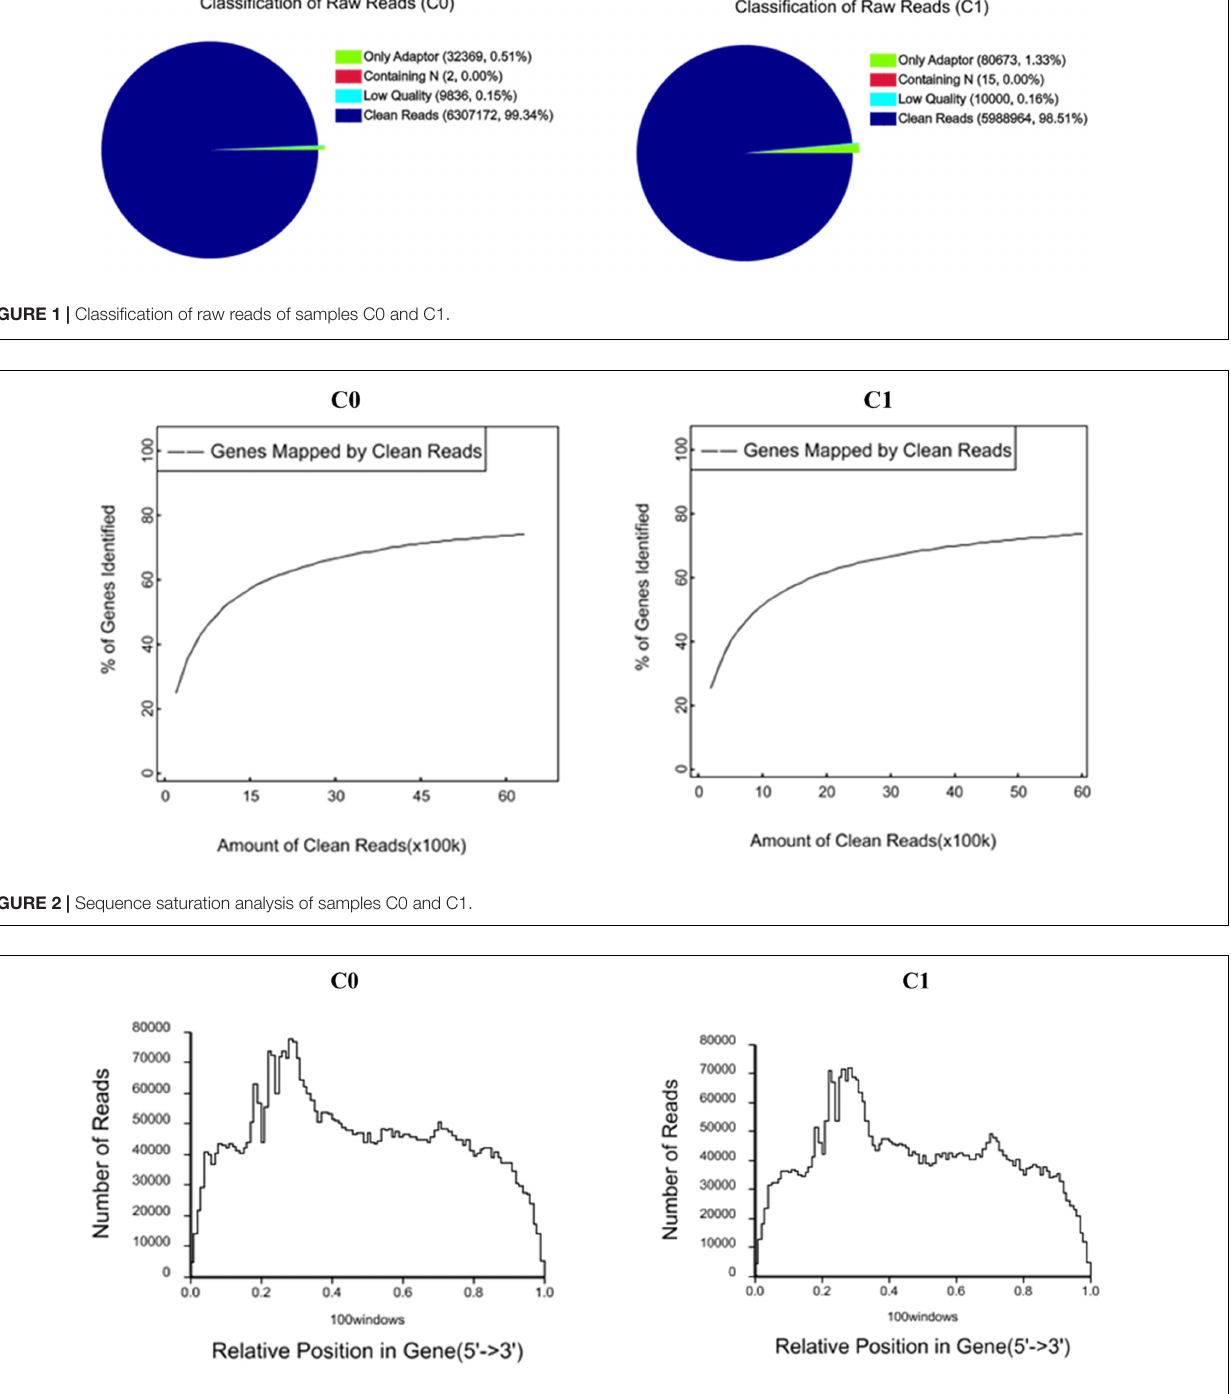
FIGURE 3 | Distribution of reads in samples C0 and C1 on reference